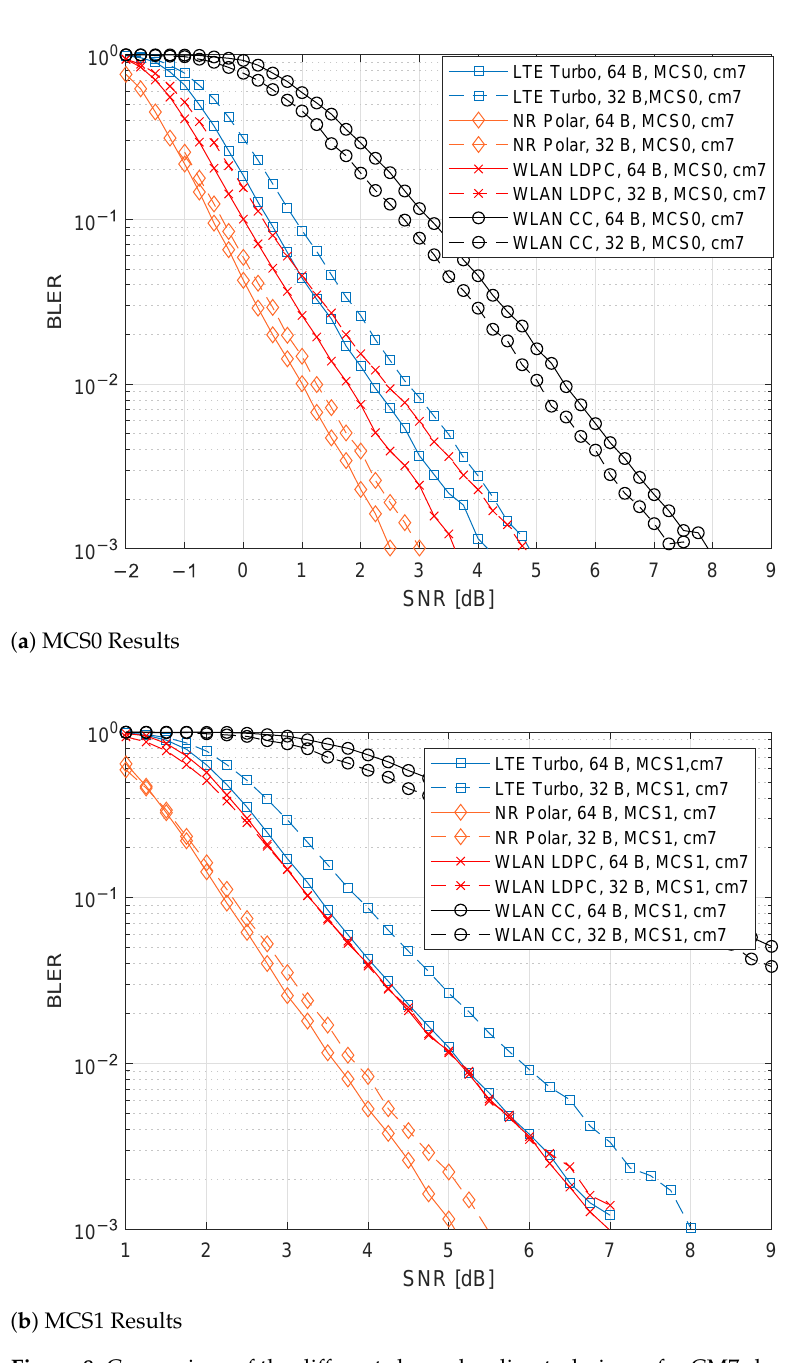
Figure 8. Comparison of the different channel coding techniques for CM7